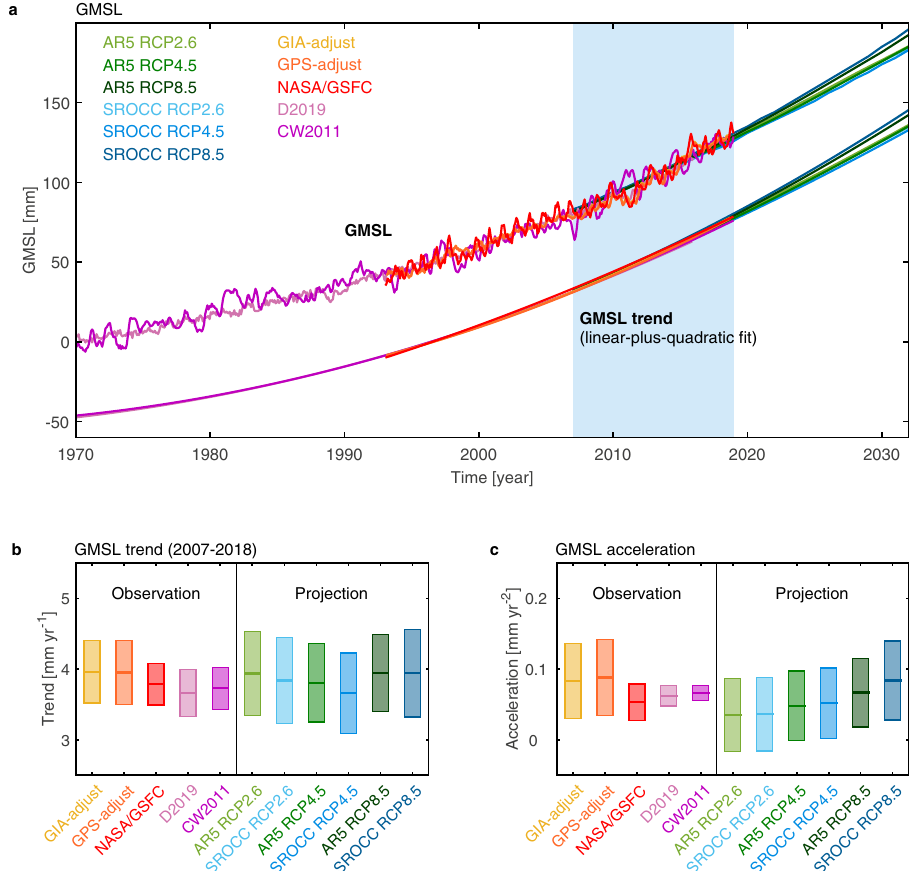
Fig. 1 The global-mean sea level (GMSL) from observations compared with projections. a Monthly satellite altimeter observations (1993 – 2018) with instrumental drifts corrected are from the Australian Commonwealth Scienti fi c and Industrial Research Organization (CSIRO) based on glacial isostatic adjustment (GIA-adjust; yellow) and Global Positioning System (GPS-adjust; orange), as well as from the National Aeronautics and Space Administration Goddard Space Flight Centre (NASA/GSFC; red). The GMSL reconstructions (1970 – 2018) from ref. 13 (D2019; light purple) and ref. 12 (CW2011; purple) are smoothed with a 5-month running-mean fi lter. The annual multimodel averaged GMSL projections from the Intergovernmental Panel on Climate Change (IPCC) Fifth Assessment Report (AR5; from light green to dark green) and Special Report on the Ocean and Cryosphere in a Changing Climate (SROCC; from light blue to dark dark blue) under three Representative Concentration Pathway (RCP) scenarios respectively (2007 – 2032). GMSL trends including both linear and quadratic terms are also shown offset by − 50 mm. The blue shaded area indicates the overlapping period between observations and projections (2007 – 2018). Box plots of b GMSL trends [mm yr − 1 ] over 2007 – 2018 and c GMSL acceleration [mm yr − 2 ] over the whole period of each dataset. Error bars indicate 90% con fi dence